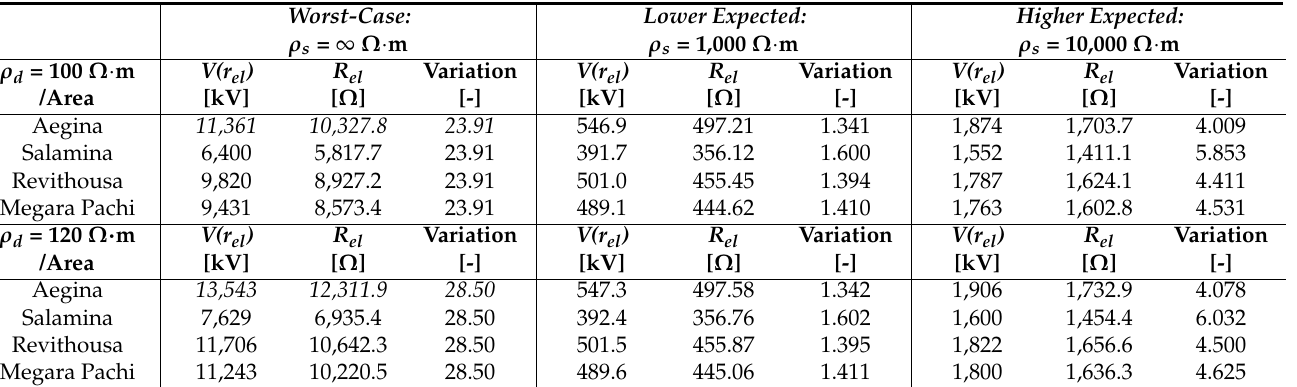
Table 4. Absolute potential at electrode surface V(r el ) and equivalent electrode resistance R el in the area of Stachtoroi, Attica, in relation to the neighboring coasts based on method “B” according to Equations (27) and (28) and variation in corresponding values in relation to method